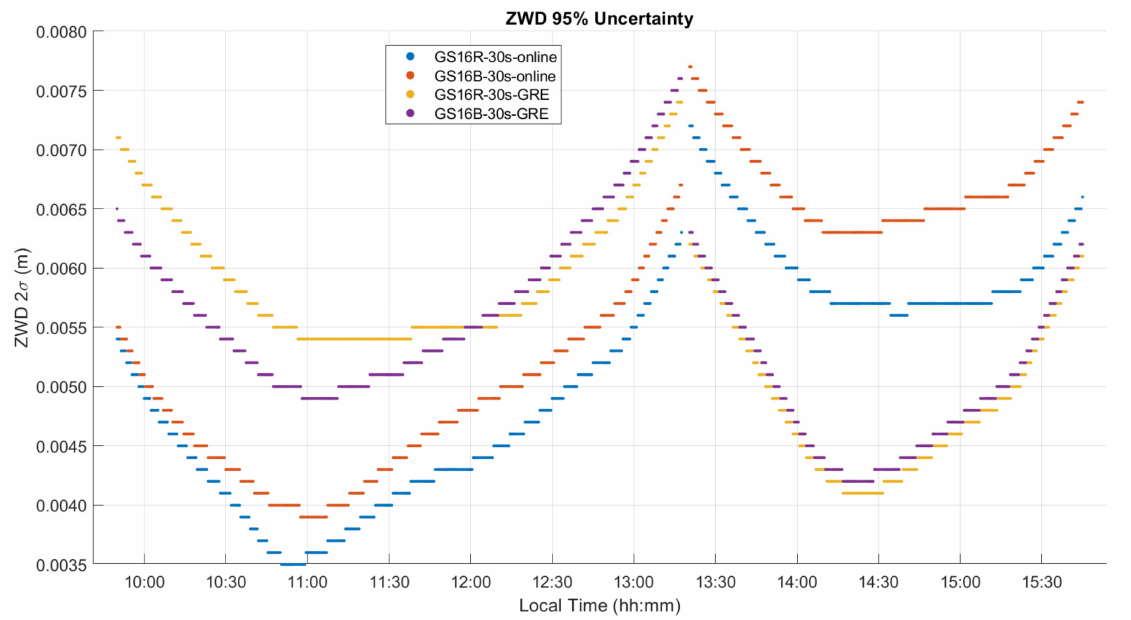
Figure 15. Kinematic dataset B ZWD profile 2 σ